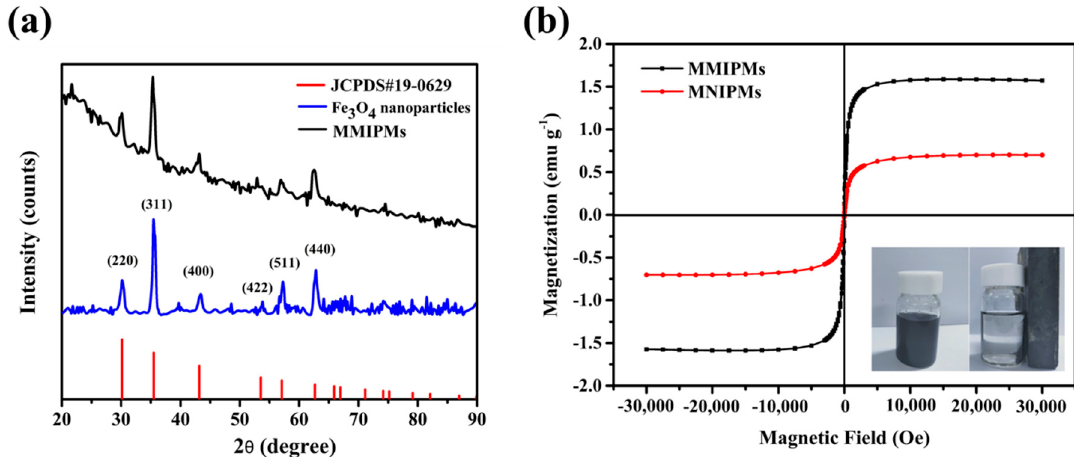
Figure 4. XRD spectrum of the synthetic Fe 3 O 4 nanoparticles and MMIPMs ( a ), and magnetic saturation curve of MMIPMs and MNIPMs ( b ).